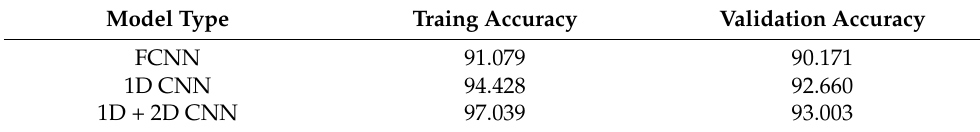
Table 3. Training accuracy and validation accuracy of the DNN models.